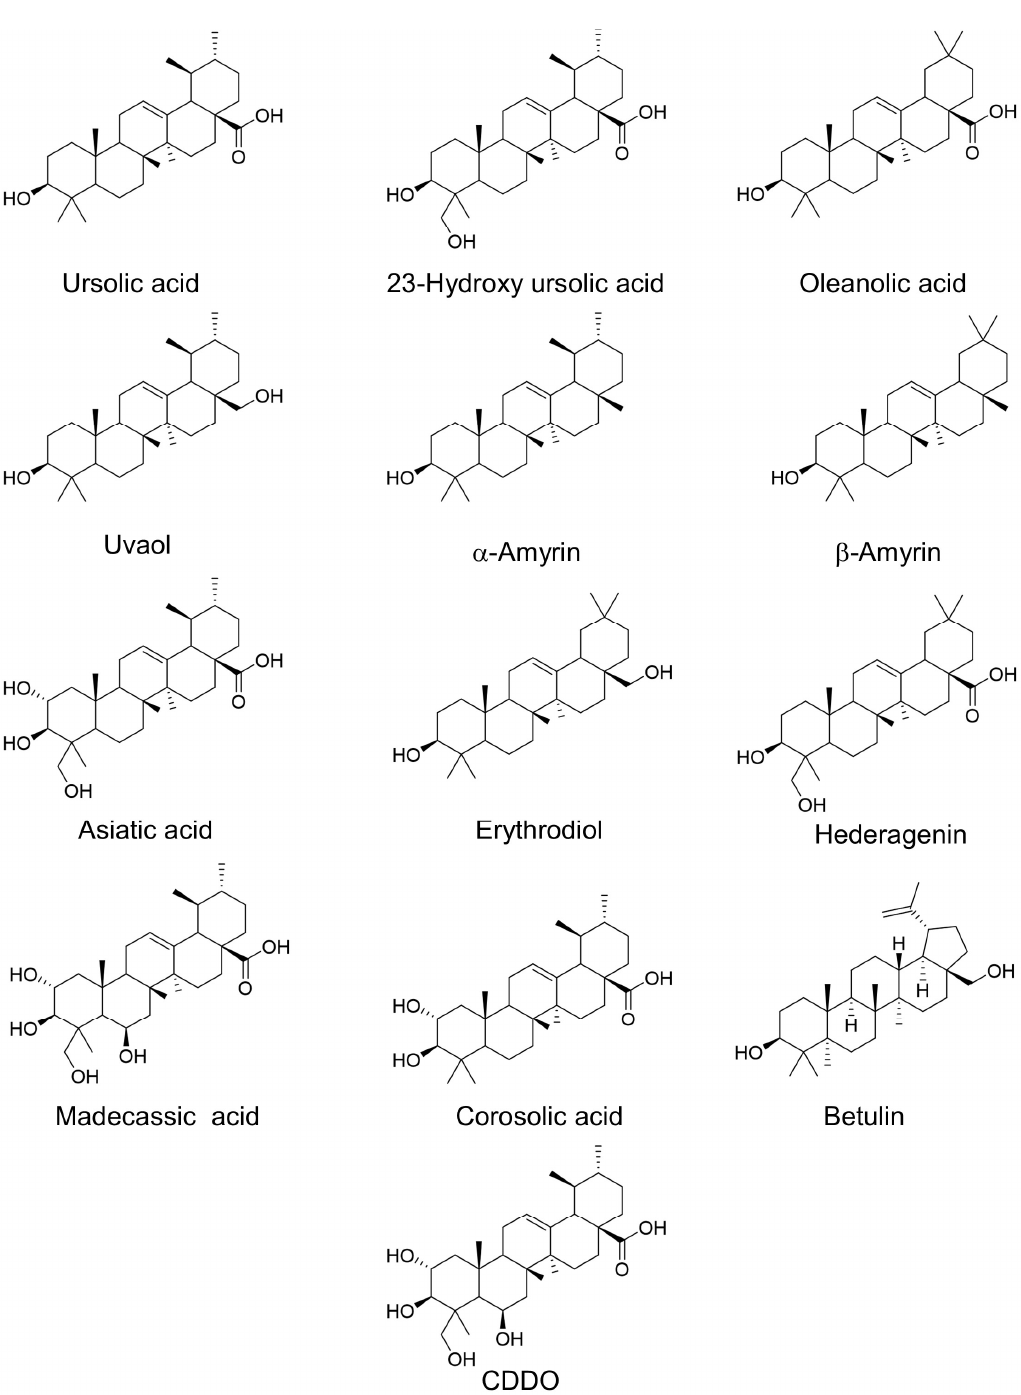
Figure 2. Structures of ursolic acid and key related pentacyclic triterpenoids.